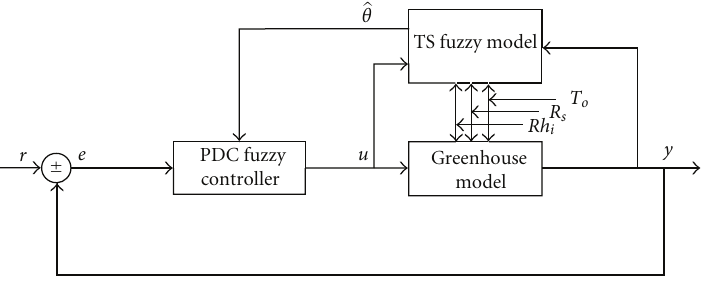
Figure 9: Adaptive fuzzy control scheme.